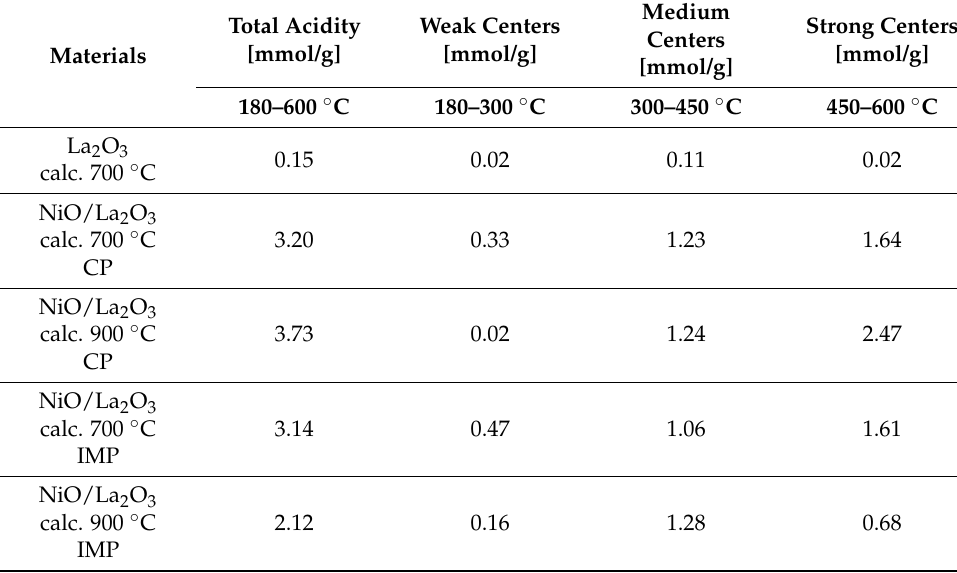
Table 5. The amount of NH 3 adsorbed on the surface of NiO/La 2 O 3 catalysts reduced at 500 ◦ C in pure hydrogen for 1 h calculated from the surface under the peaks recorded during the TPD-NH 3